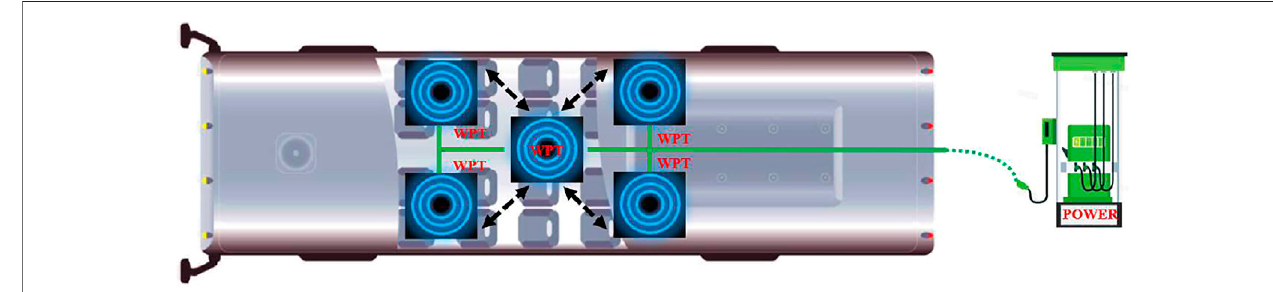
FIGURE 1 | Modular high-power wireless charging system for electric vehicles.